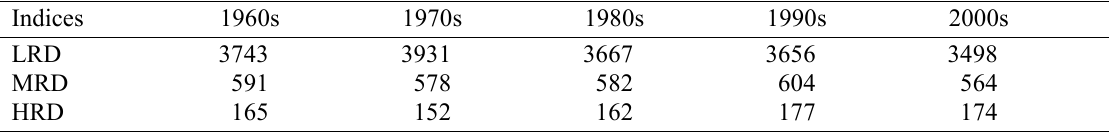
Table 2 Decadal changes of rainy days at different levels.